Question: Provide a one-line summary of what is displayed.
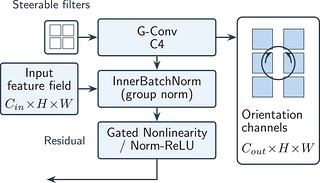
Answer: Diagram of the equivariant R2Conv block used within the U‐Net based network for the reverse diffusion process.